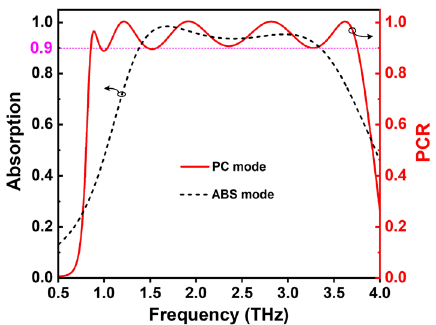
Figure 3. Performance of RMSs for ABS and PC modes.